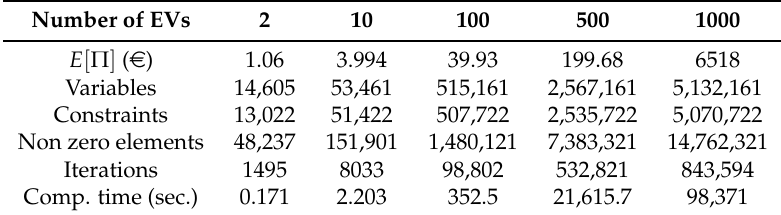
Table 5. Model Statistics while increasing the number of EVs.